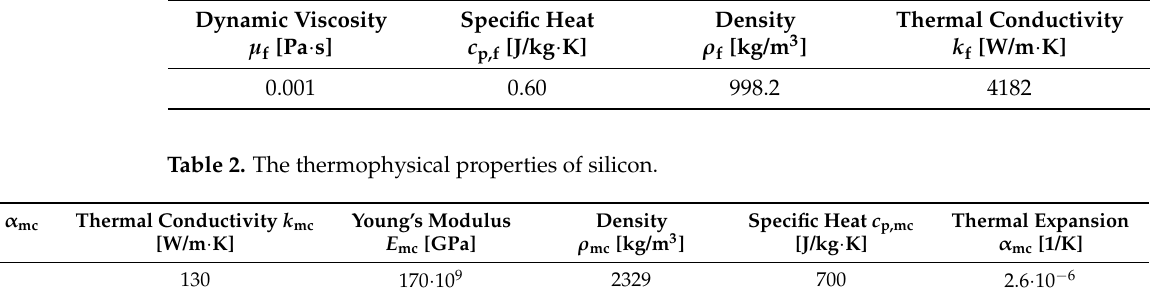
Table 1. The thermophysical properties of water ( T = 300 K).